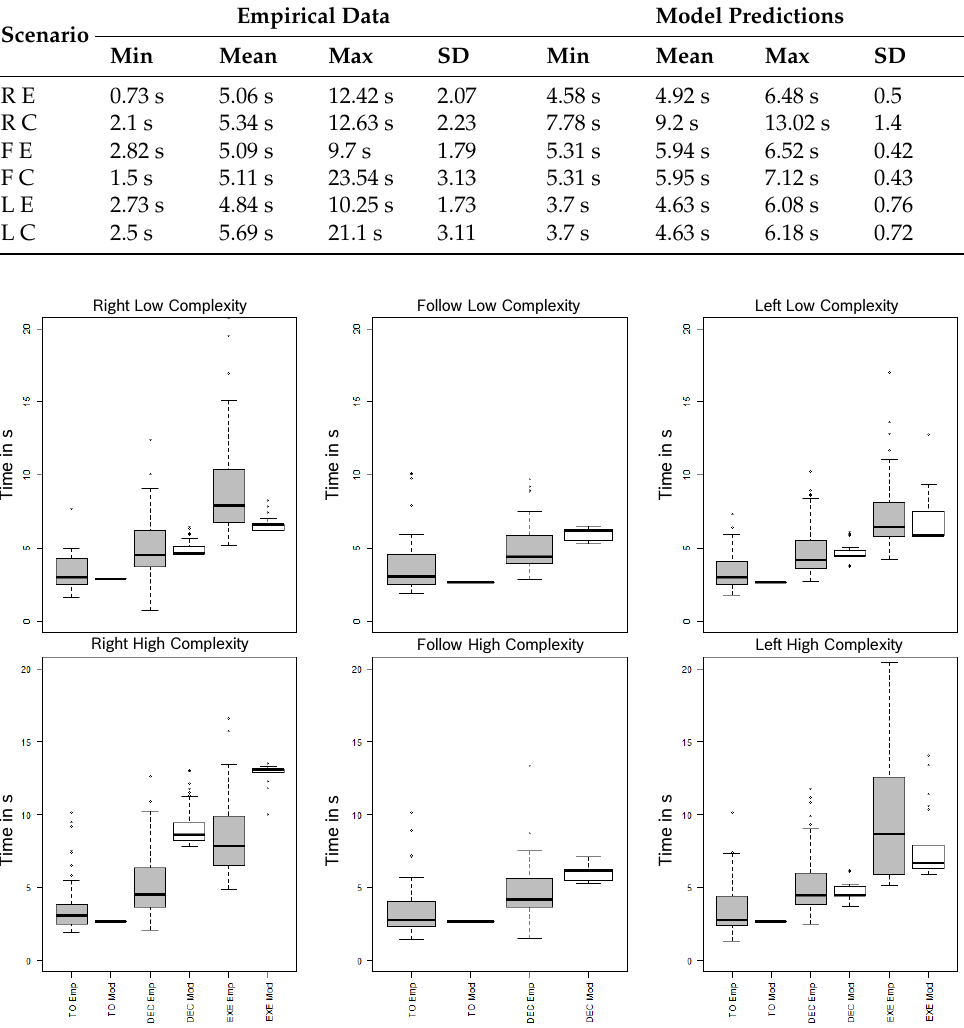
Figure 7. Box-Whisker plot of empirical data (Emp, gray) and model predictions (Mod, white) for the timeline in seconds (s) on the y-axis of the takeover (TO) and the time of the action decision (DEC). In right and left maneuver cases, the time of the action execution (EXE) is also included (source: own